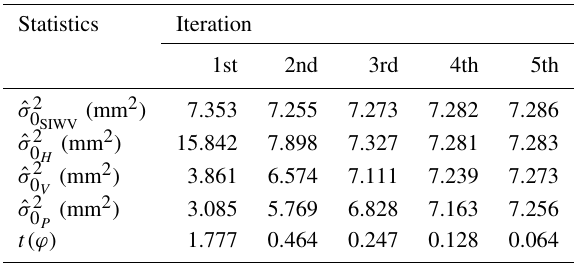
Table 1. Posterior unit variances for different input equations and test statistics calculated by using the proposed method for Scheme